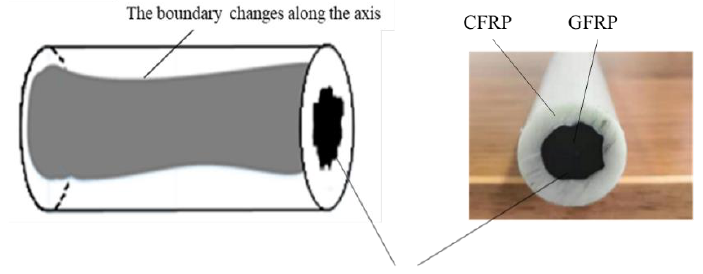
Figure 2. Carbon fiber sucker